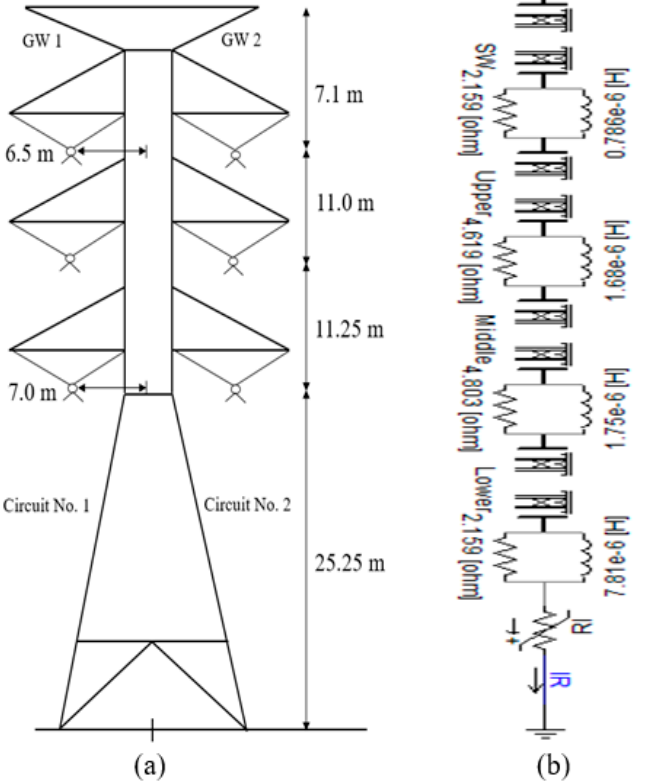
Figure 8b. Subsequently, the Bergeron model in the PSCAD software was chosen in this study to develop the tower modelling for transient simulation in the time domain. The Bergeron model is a technique for determining how a reflection affects an electric signal. This model is the simplest and most accurate of the PSCAD distributed branch models, mainly due to the fact that it is not frequency-dependent [57,58].